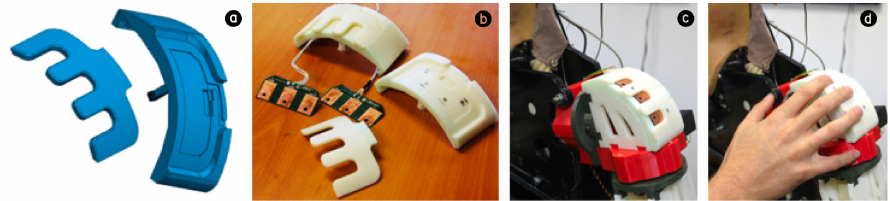
Figure 6. Development and integration of the TMP electronic patches in the shoulder of the body designed for FACE; ( a ) CAD project of the TMP patches; ( b ) realisation of the TMP patches; ( c ) integration of the TMP patches in the FACE body; ( d ) interaction with the TMP